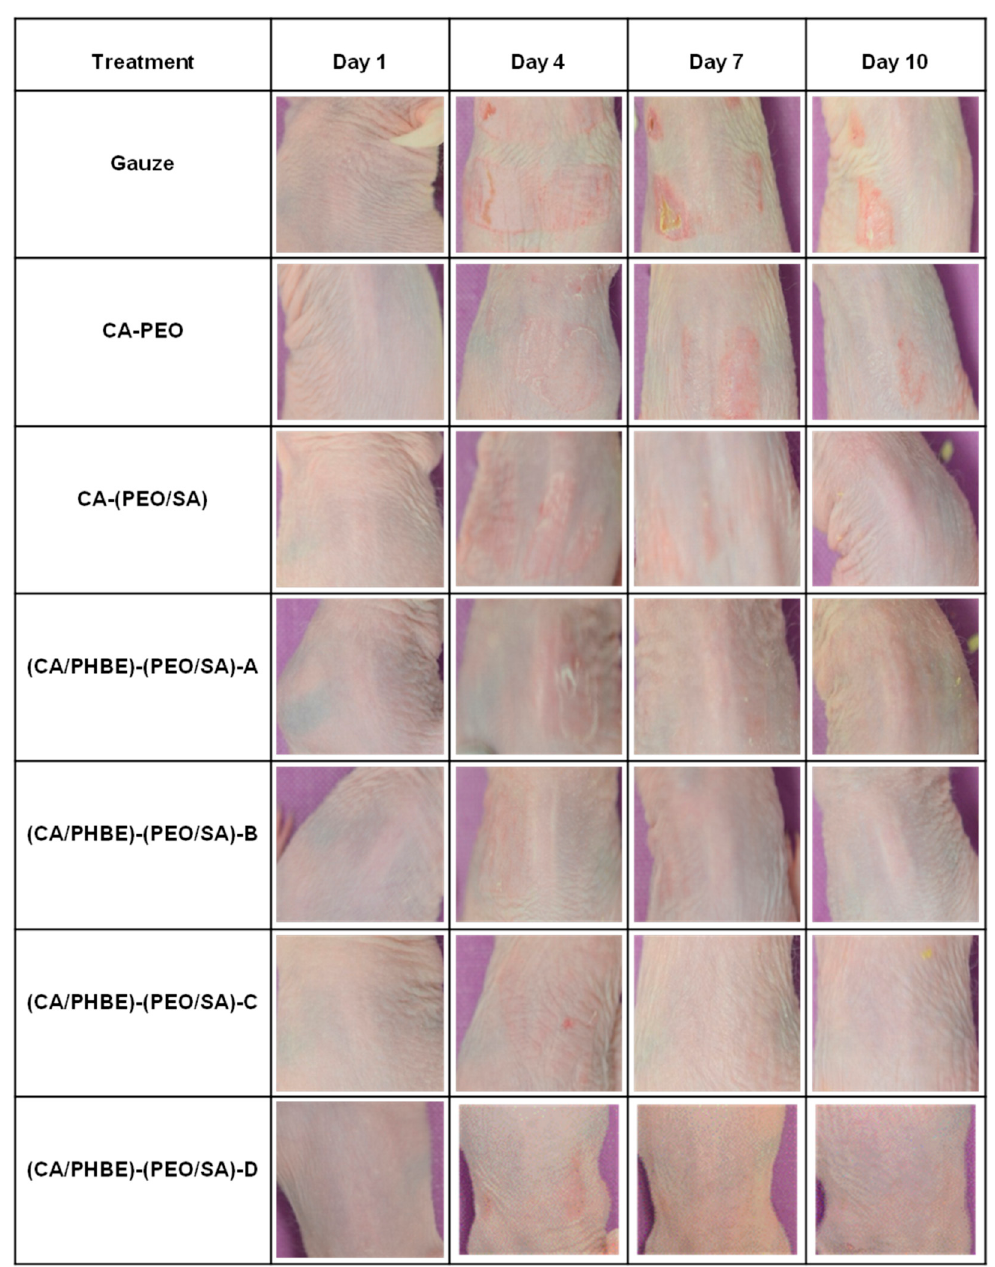
Figure 4. Representative images of the mice back skin before (day 1), during (days 4 and 7) and at the end (day 10) of the treatment period.